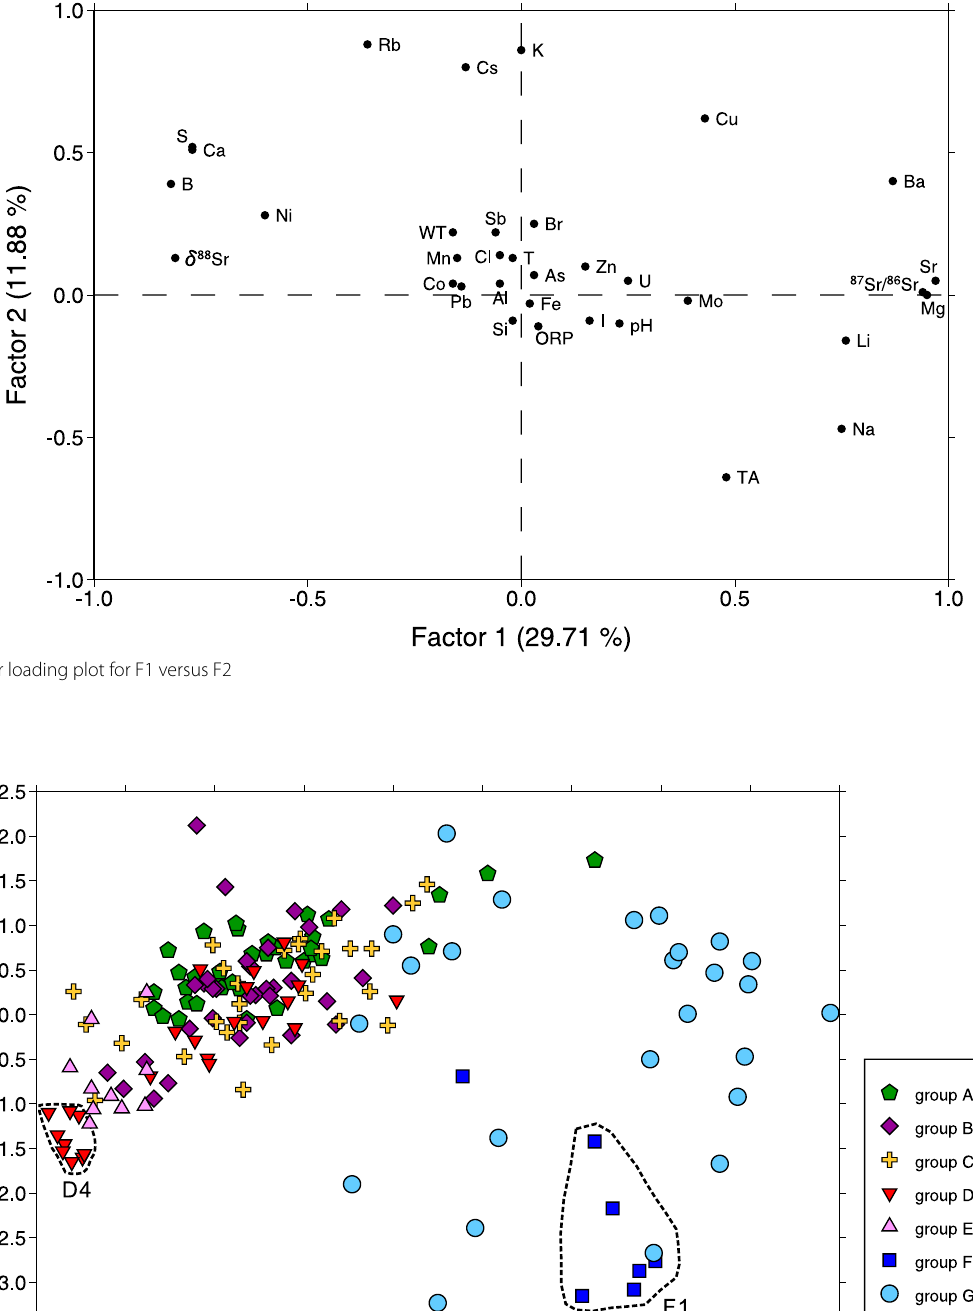
Fig. 5 Factor score plot for F1 versus F2. Mud pools D4 and F1 are marked with dashed circle because of relatively small